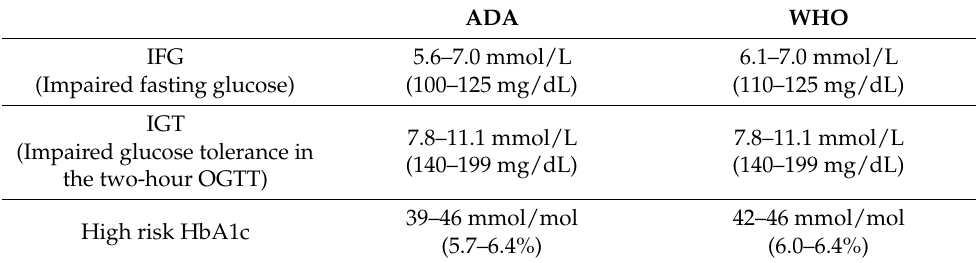
Table 1. Pre-diabetes according to ADA and WHO